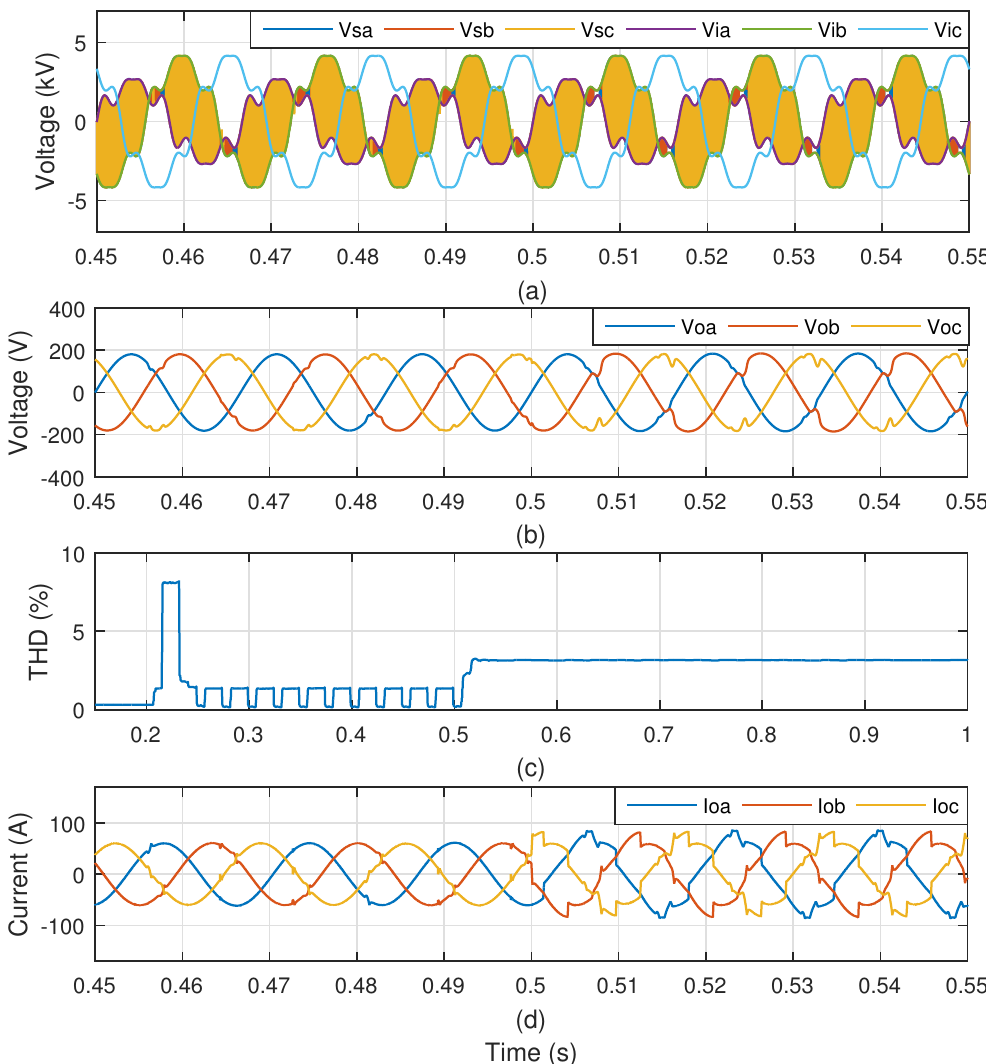
Figure 18. AC-AC 2 × 3 DMC operation. ( a ) Output switched voltage along with input voltage, ( b ) output voltage, ( c ) output voltage THD, and ( d ) output